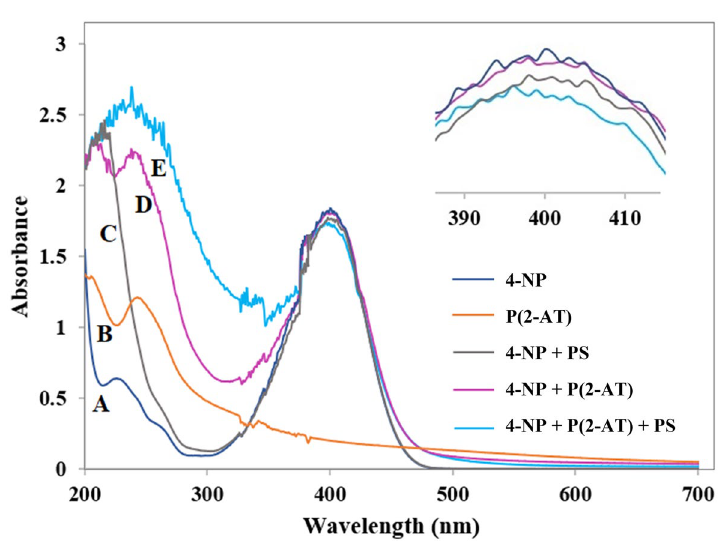
Figure 6. UV–Vis of an aqueous solution of 4-NP ( A ), P(2-AT) ( B ), 4-NP treated with persulfate after 3 h ( C ), 4-NP treated with P(2-AT) after 3 h ( D ), 4-NP after P(2-AT)-based AOP after 3 h ( E ), catalyst: 0.003 g, persulfate: 0.0015 g, 25